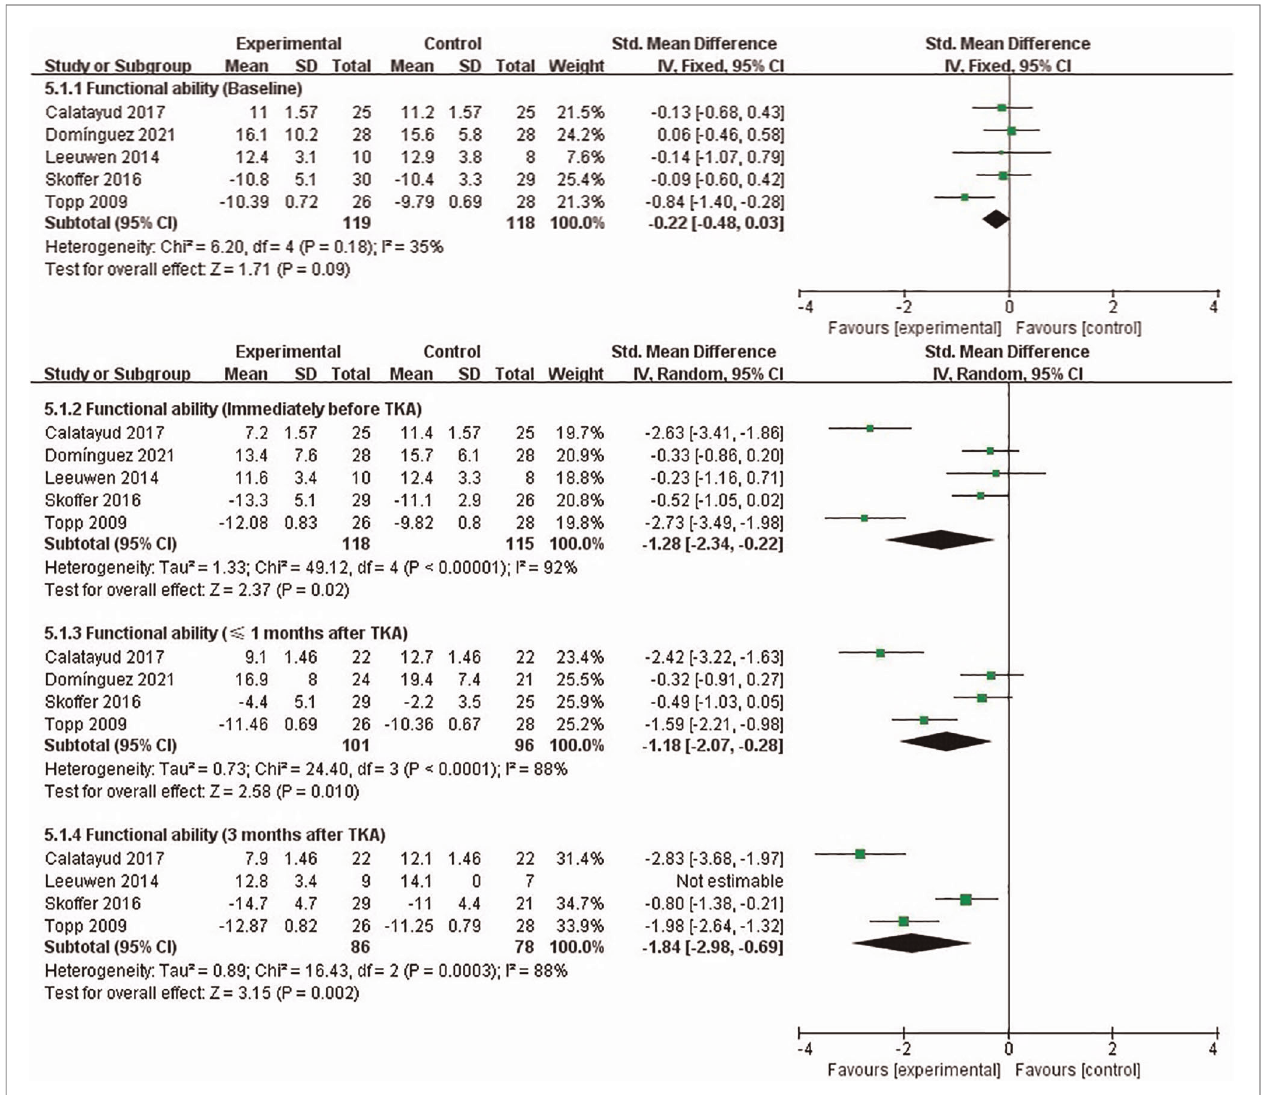
FIGURE 7 | Meta-analysis on Functional